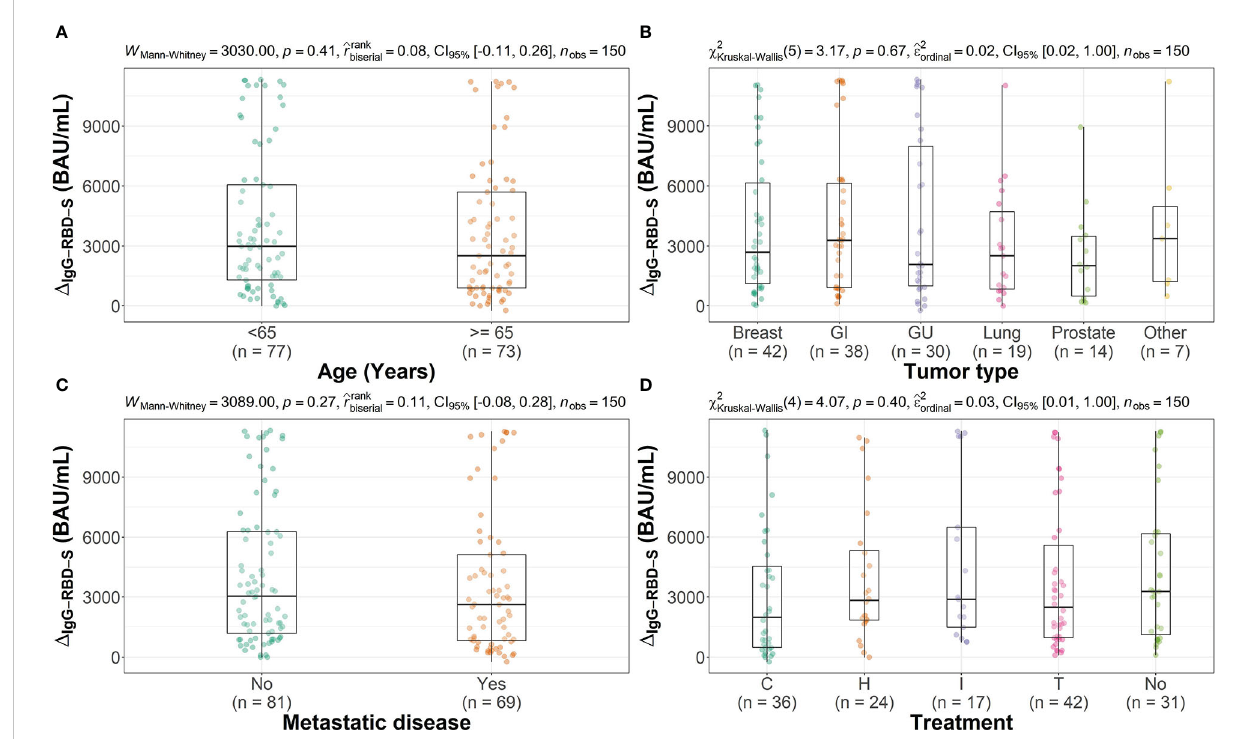
FIGURE 3 Distribution of the increment in IgG-RBD-S value (IgG-RBD-S T2 - IgG-RBD-S T1 ), expressed in BAU/mL, across groups for different characteristics. ( A : Age, B : Tumor type, C : presence of metastatic disease, D : type of treatment) Each box covers the interquartile range; the splitting line is the median and whiskers represent minimum and maximum values. Statistical signi fi cance, set at p-value <0.05, was assessed using the Mann-Whitney U test or the Kruskal-Wallis test. (G, Gastrointestinal; GU, Genitourinary; C, Chemotherapy; H, Hormone therapy; I, Immunotherapy; T, Target therapy; No, No